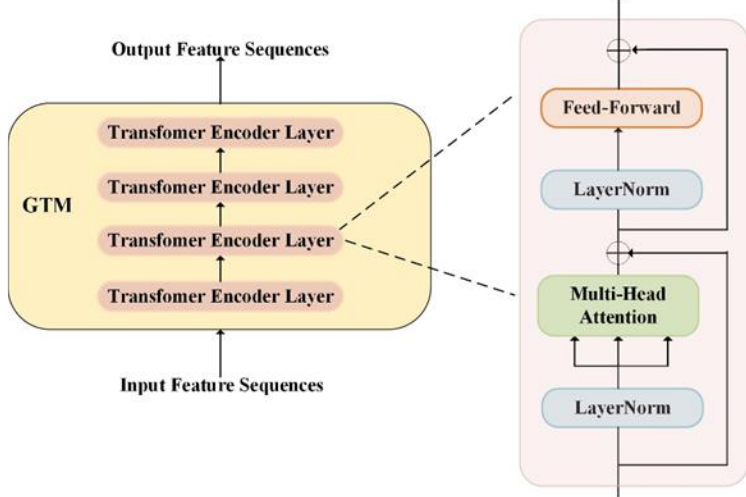
5 of 17 Figure 2. The pipeline of our framework. GTM: Global Transformer Module. DFE: Detailed Feature Enhancement Module. 3.1. Global Transformer Module The human body has a semantic structure context prior to be analysed. Thus, cap- turing the context information from a global perspective can effectively reduce parsing prediction errors, especially for occlusion, and similar appearance categories. Some pre- vious methods implicitly extracted the structural information by deepening the convolu- tional layers, but it is difficult to obtain richer global context information. Based on the previous work with CE2P, the PPM pools the shared features extracted from the fifth layer in the residual network and generates 1 × 1, 2 × 2, 3 × 3, 6 × 6 multiple scale context features. To exploit the power of the semantic structure context fully, we introduce the GTM (Fig- ure 3) which integrates global context information from the pyramid pooling module. The context features are upsampled by bilinear interpolation to keep the same size as the orig- inal feature map. Then, fusion features obtained by 1 × 1 convolution reduction channels are input into the GTM as feature sequences. One encoder passes the input feature se- quences to the self-attention layer and feed-forward networks for processing, and the out- put result is passed to the next encoder. Unlike the standard transformer, which adopts the original six layers structure, our encoder is composed of four encoder layers with the